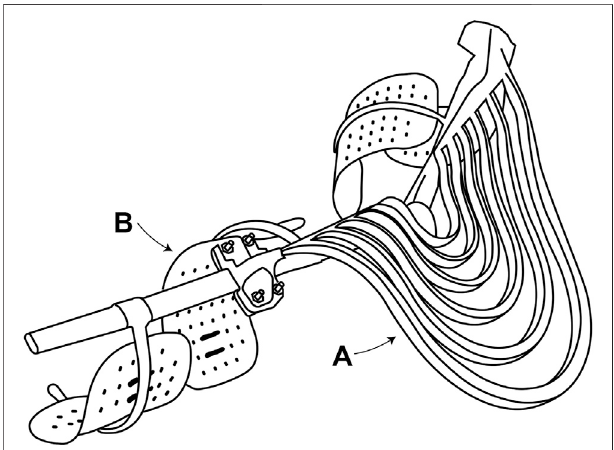
FIGURE6| TheAssistiveElbowOrthosis. (A) Lateralstackof3D-printed nested gravity-balancing springs. (B) Metal brace with plastic supports [Wilmer elbow orthosis Plettenburg (2007)].